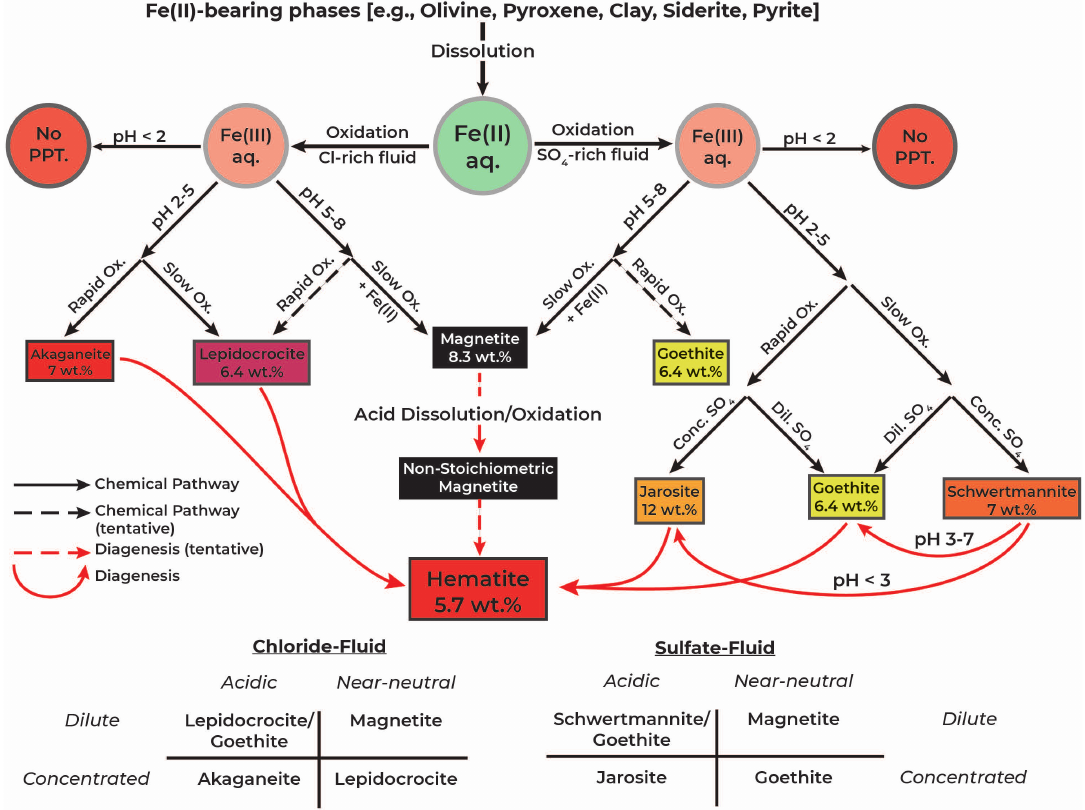
Figure 3. (Top) Schematic of possible iron oxidation pathways on Mars. Mineral products of iron oxidation determined by the fluid type, solution pH, and oxidation rate. The wt.% in each mineral box represents the amount of Fe(III)-bearing mineral that can be produced by the oxidation of Fe(II) by 1 wt.% chlorate. (Below) Fourfold diagram depicting the dominant mineral product as a function of fluid concentration and solution